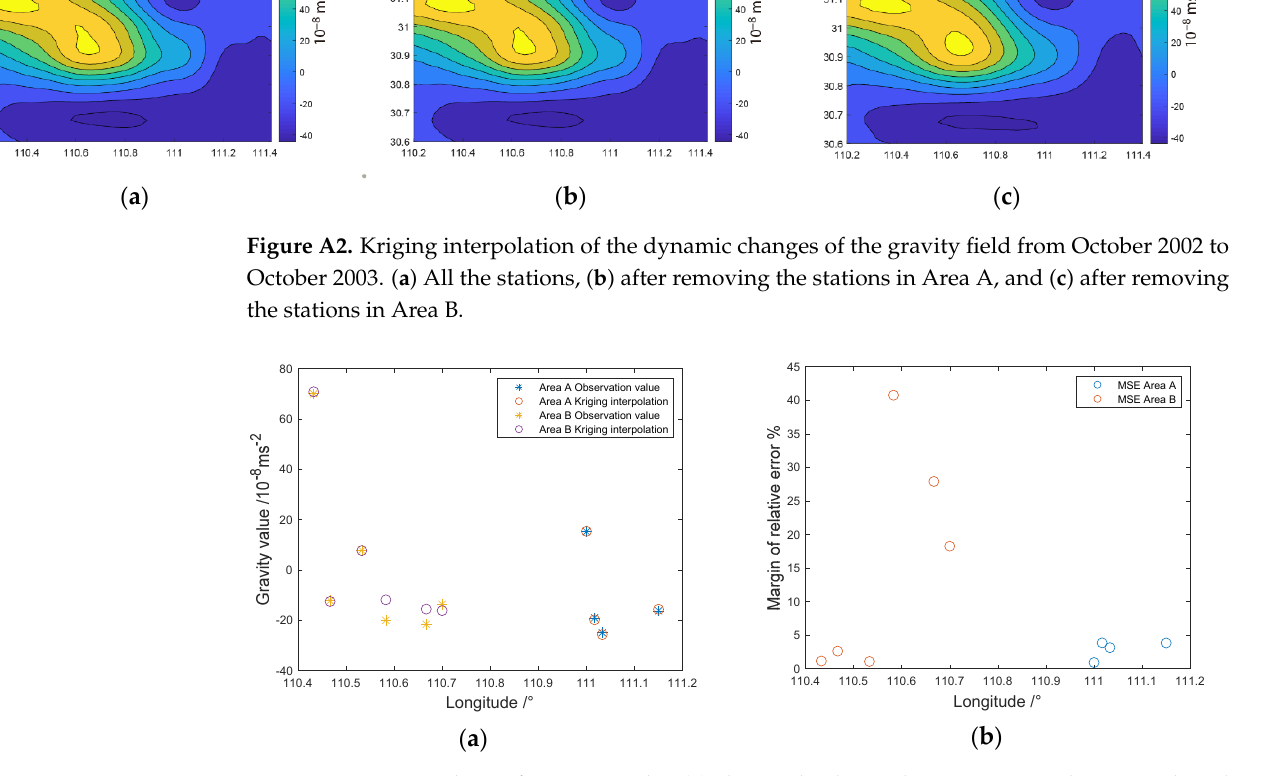
Figure A3. Error analysis of Areas A and B: ( a ) observed value and Kriging interpolation result and ( b ) distribution of relative error.